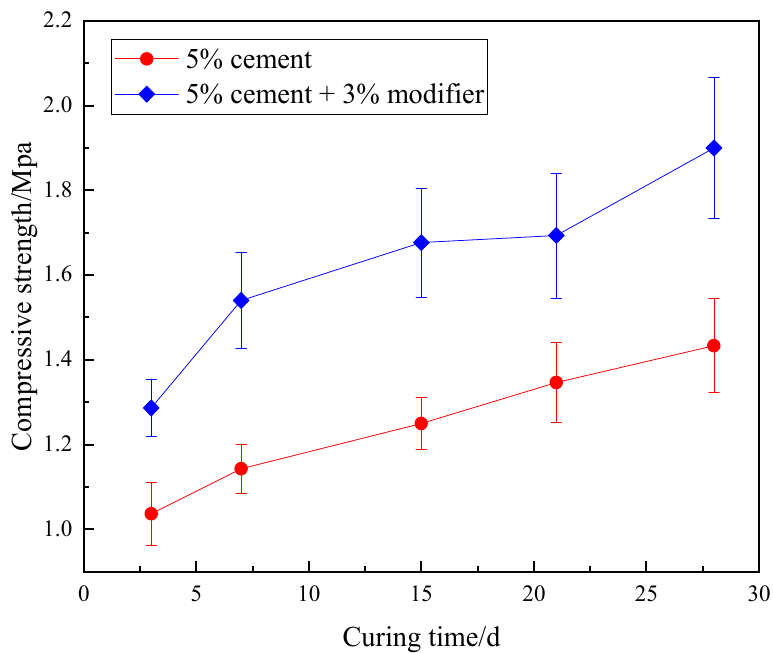
Figure 7. Influence curves of curing time on compressive strength.